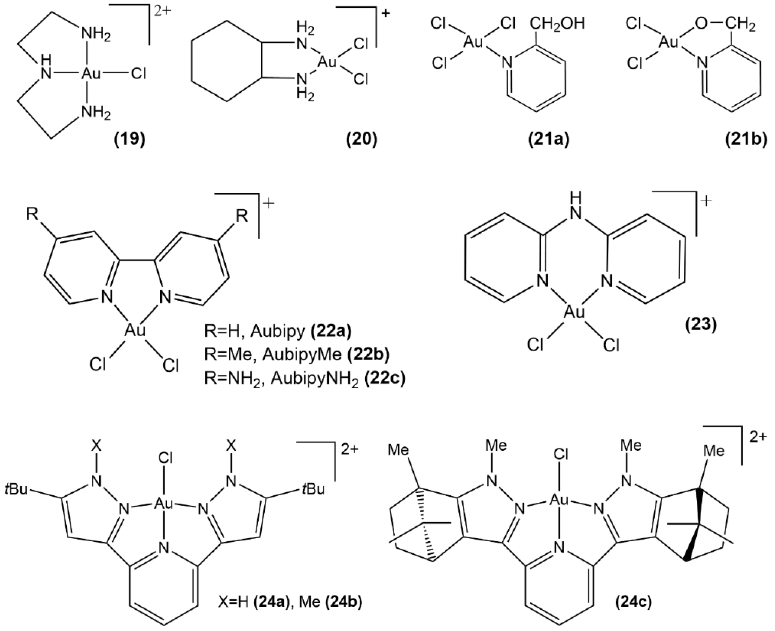
Figure 14. Au(III) complexes with azapentanediamine ( 19 ), diaminocyclohexane ( 20 ), pyridines ( 21a , 21b ), bipyridyl ( 22a – 22c ), dipyridin-2-ylamine ( 23 ), bispyrazolpyridine ( 24a , 24b ) and bi- sindazolpyridine ( 24c ). dine ( 24c